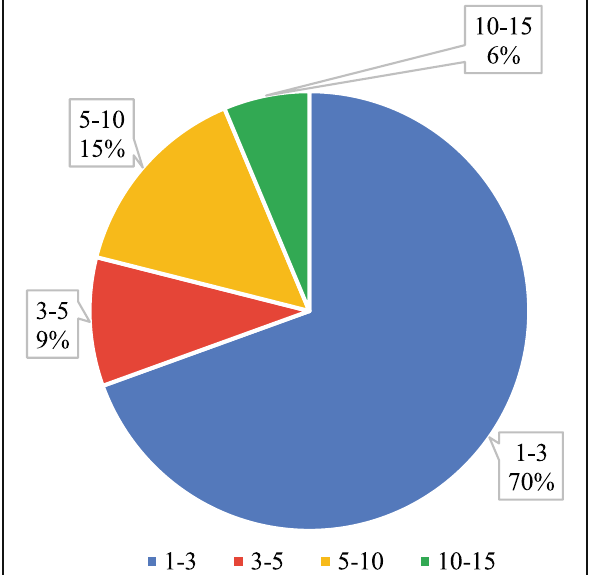
Fig. 2 Practical experience of participants in CT scan